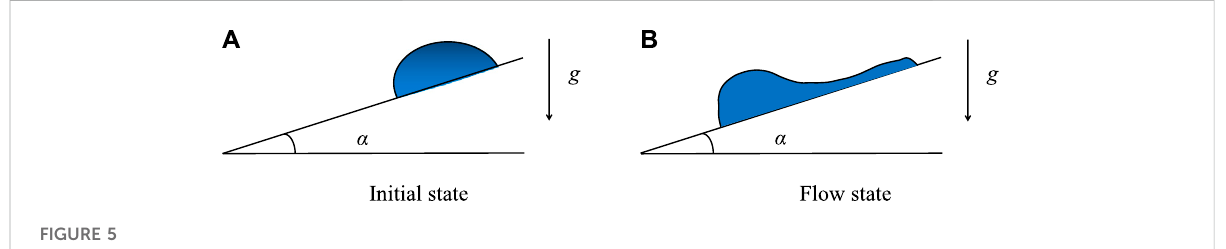
FIGURE 5 Schematic diagram of fl uid fl ow on a slope: (A) initial state and (B) fl ow